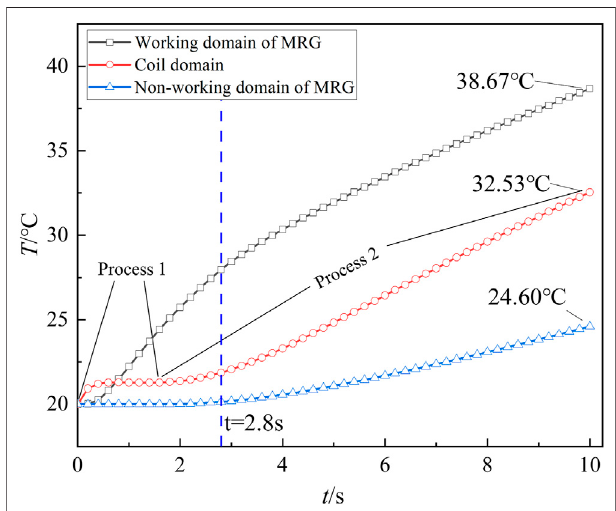
FIGURE 12 | Temperature rise curve of each domain in working condition Ⅱ